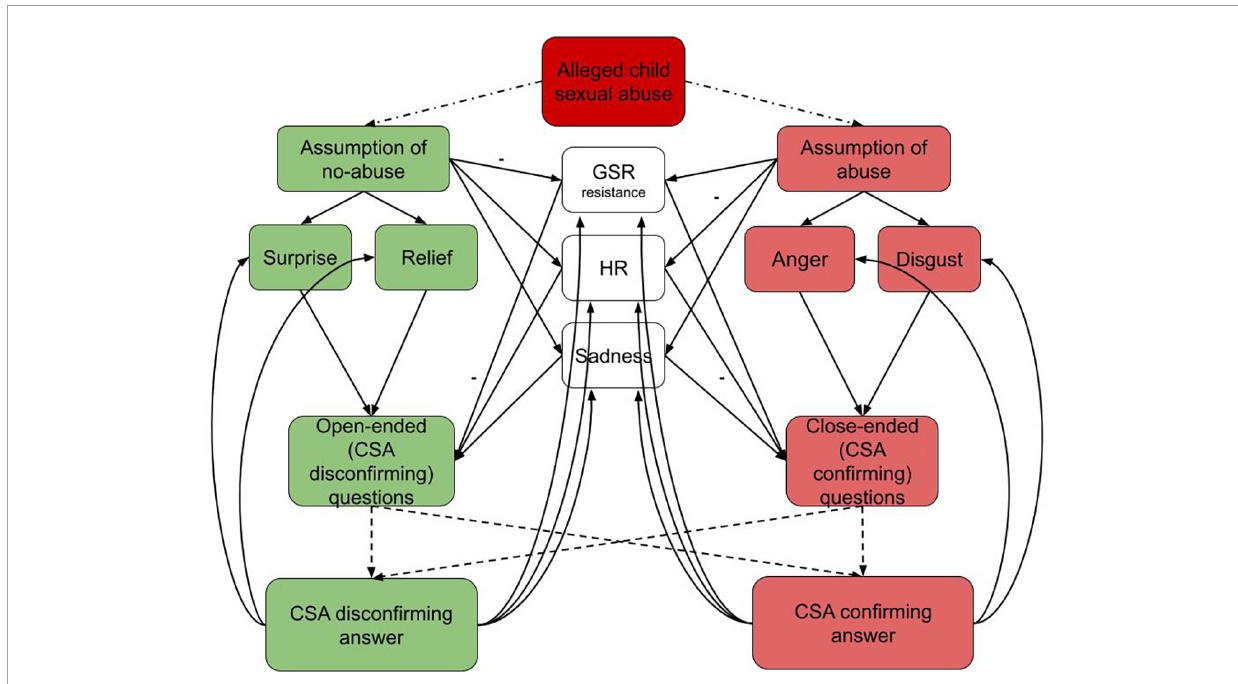
FIGURE1 A preliminary model of the role of emotions on confirmation bias in question formulation in investigative child sexual abuse (CSA) interviews.